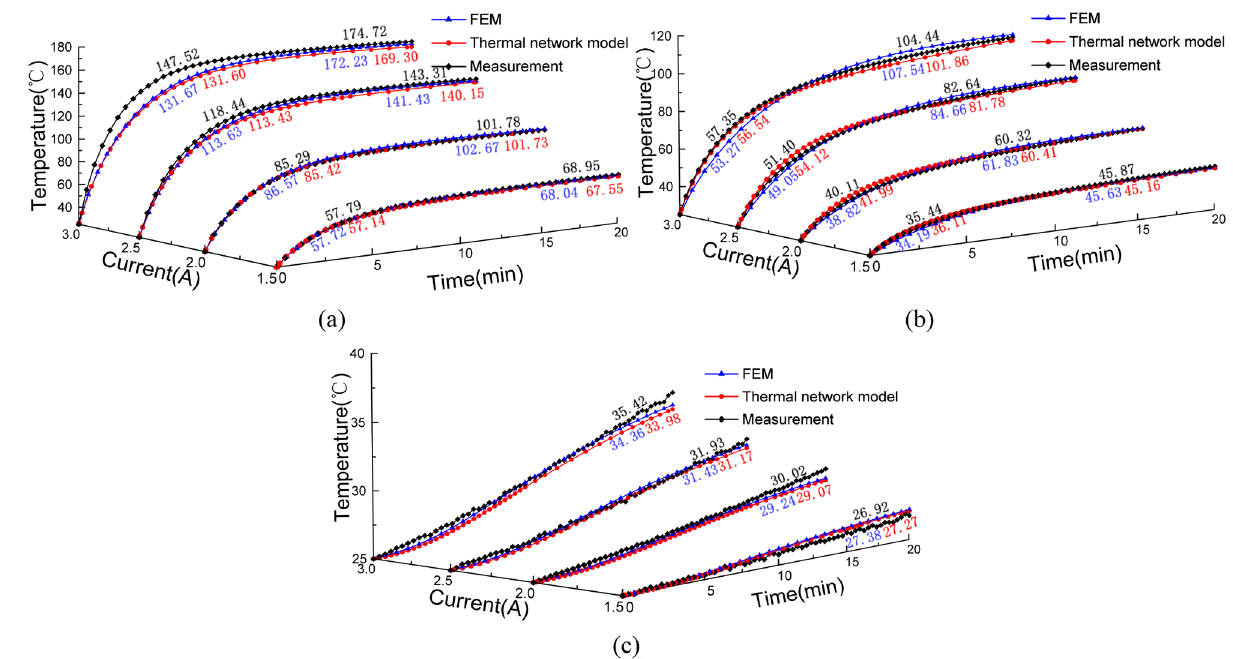
Figure 13. Comparison of measured values and model results of temperature rise at different positions of GMT: ( a ) The central surface of GMM rod, ( b ) The inner wall of excitation coil, ( c ) The inner wall of